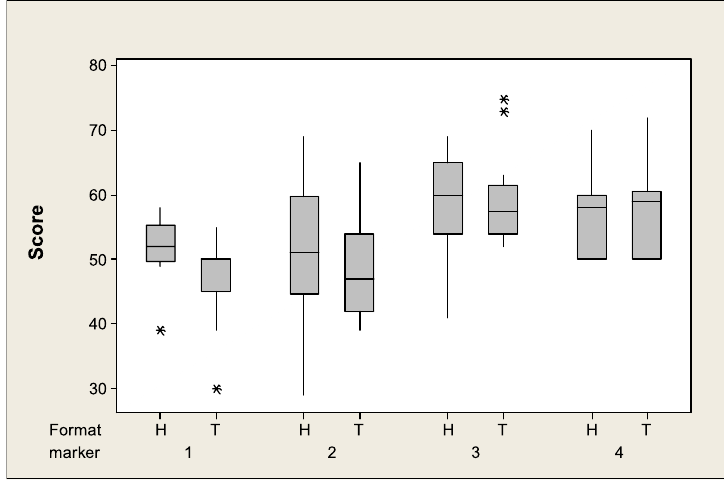
Figure 5. Boxplot of score by marker then